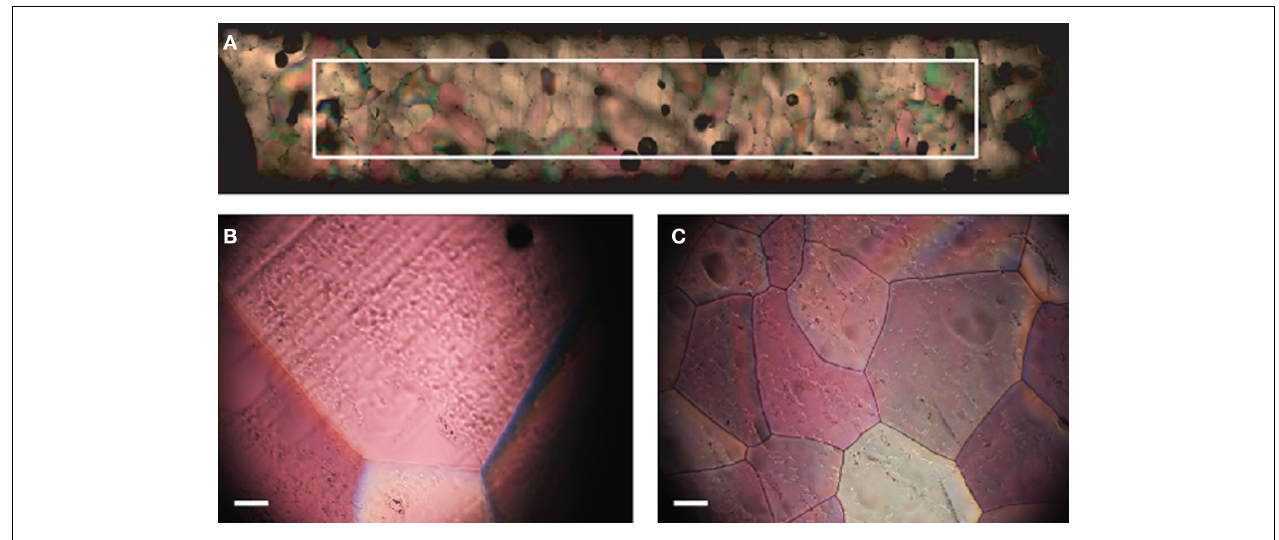
Ice structure formed from filtered deionized water. (C) Ice structure formed in the presence of extracellular proteins from 3519-10. Scale bars in (B) and (C) are 0.1mm.